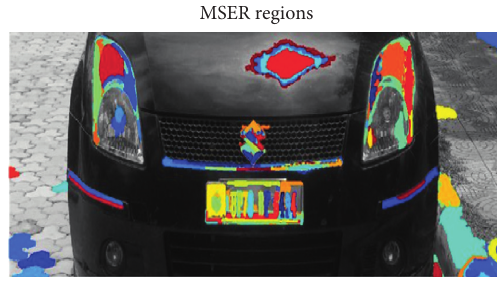
Figure 12: Detected MSER within a maximum and minimum threshold area.